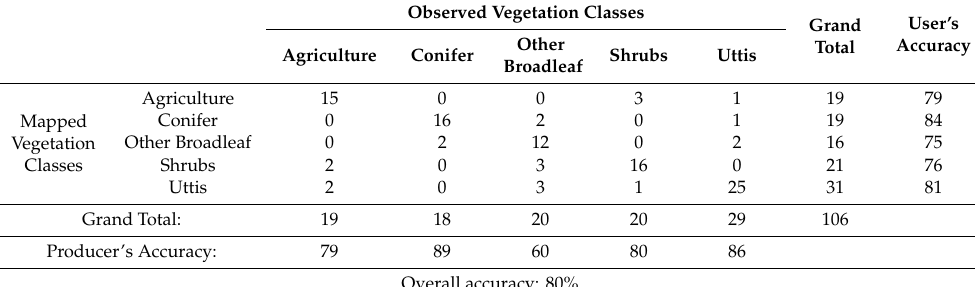
Figure 4. ( a ) Spatial distribution of Uttis tree cover, ( b ) spatial distribution of cardamom under Uttis tree and standalone Uttis tree cover. Table 1. Contingency matrix for accuracy assessment.